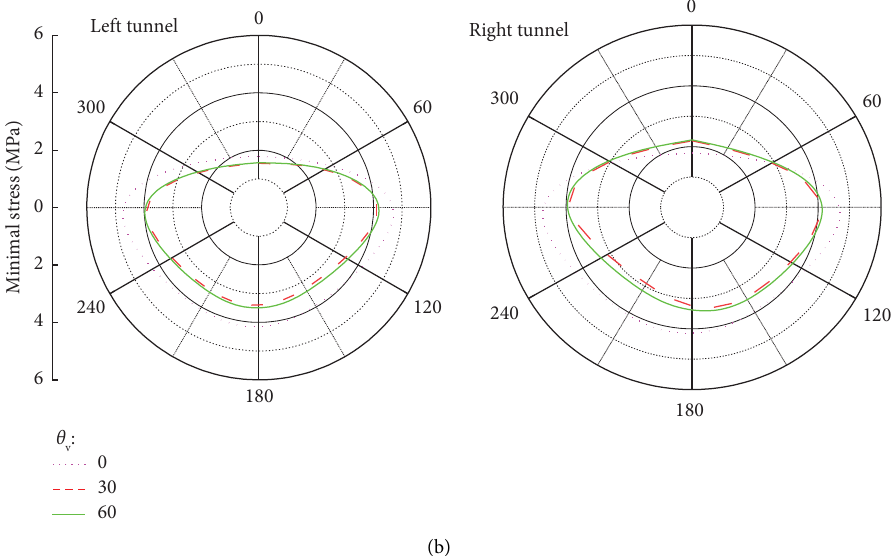
Figure 9: Amplitude distribution of principal stress when SV wave is incident at 15: (a) maximum principal stress and (b) minimum principal